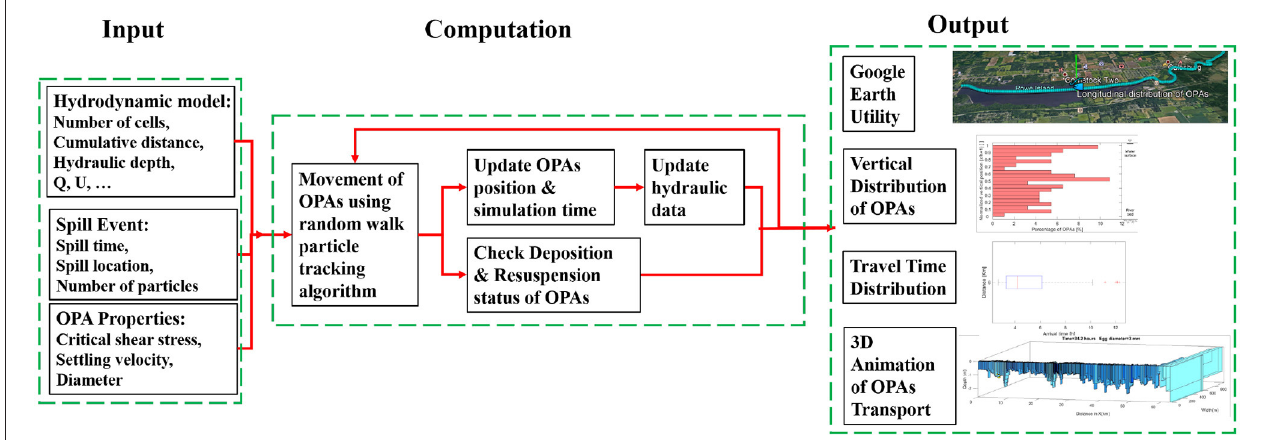
FIGURE 1 | Structure of the FluOil model. Output can be visualized by functionalities in FluOil as well as Google Earth (Google Keyhole, Inc.,